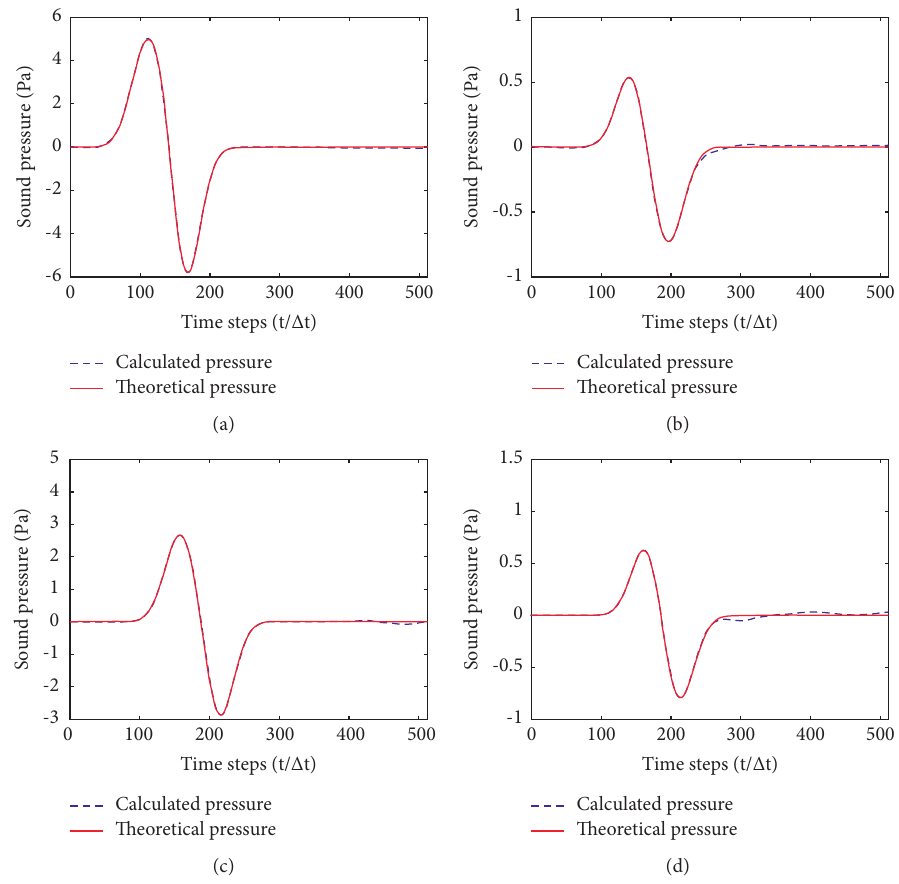
Figure 8: The calculated time signals at the two points P � 0.2m and P z r 1 (c) and P 2 (d) on plane